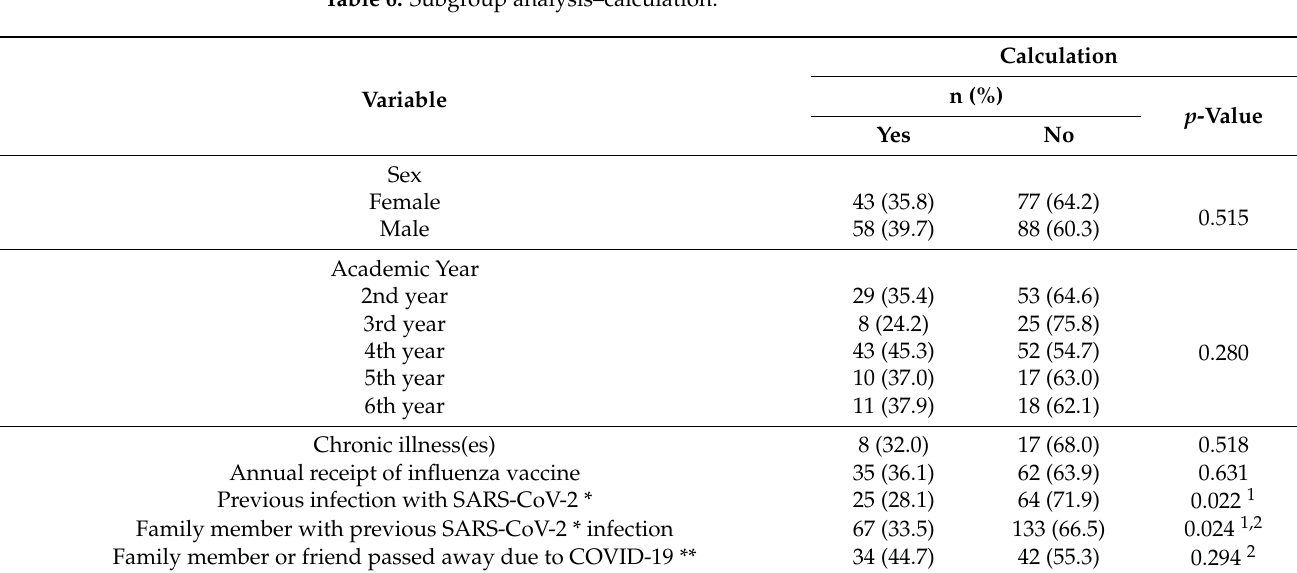
Table 6. Subgroup